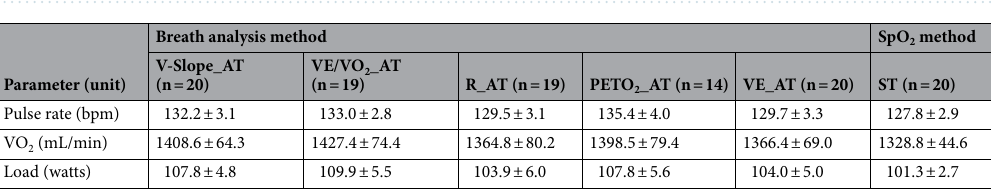
Figure 2. ( a ) Representative SpO 2 and PR time series data during cardiopulmonary exercise testing. SpO 2 percutaneous oxygen saturation, PR pulse rate, Bpm beats per minute. ( b ) Distribution of SpO 2 corresponding to ST. SpO 2 was distributed in the range of 97–100%. SpO 2 percutaneous oxygen saturation, ST percutaneous oxygen saturation threshold.